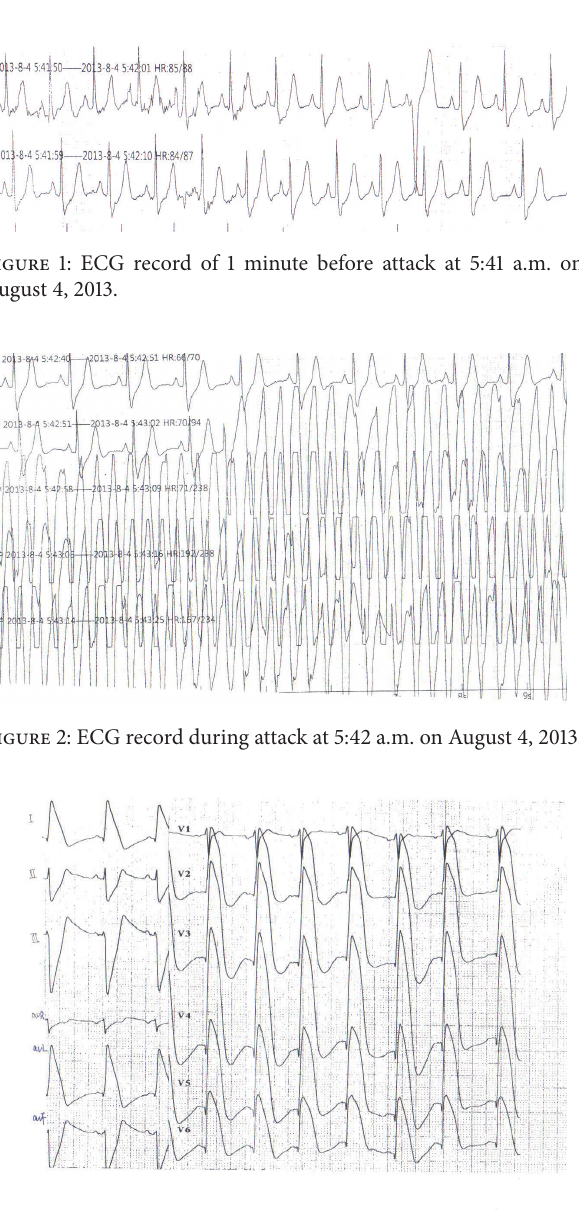
Figure 3: ECG record of 8 minutes after attack at 5:50 a.m. on August 4, 2013.